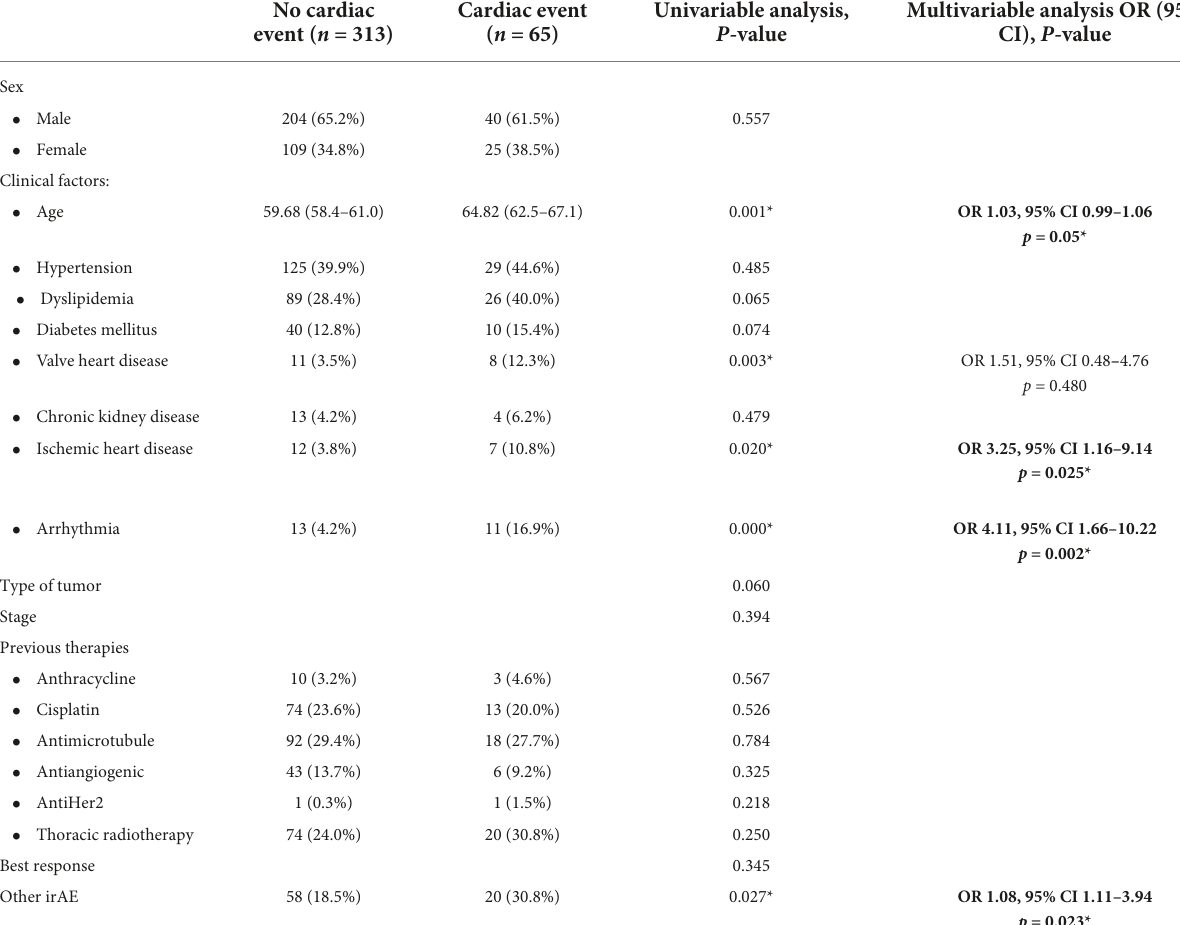
TABLE 4 Univariable and multivariable Cox regression